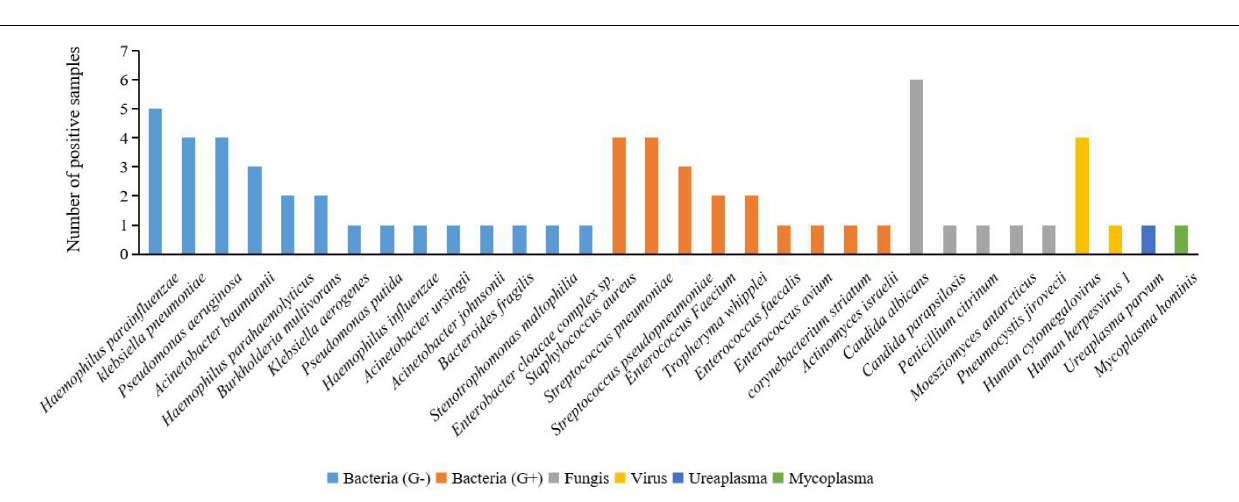
FIGURE 3 | Positive pathogen spectrum detected in BALF samples by mNGS in this study. Of all the bacteria detected by mNGS in BALF samples, G-bacteria ( Haemophilus parainfluenzae , klebsiella pneumoniae , and Pseudomonas aeruginosa ) made up the majority. Several rare pathogens were also detected in the BALF samples, such as Penicillium citrinum , Ureaplasma parvum , and Mycoplasma hominis